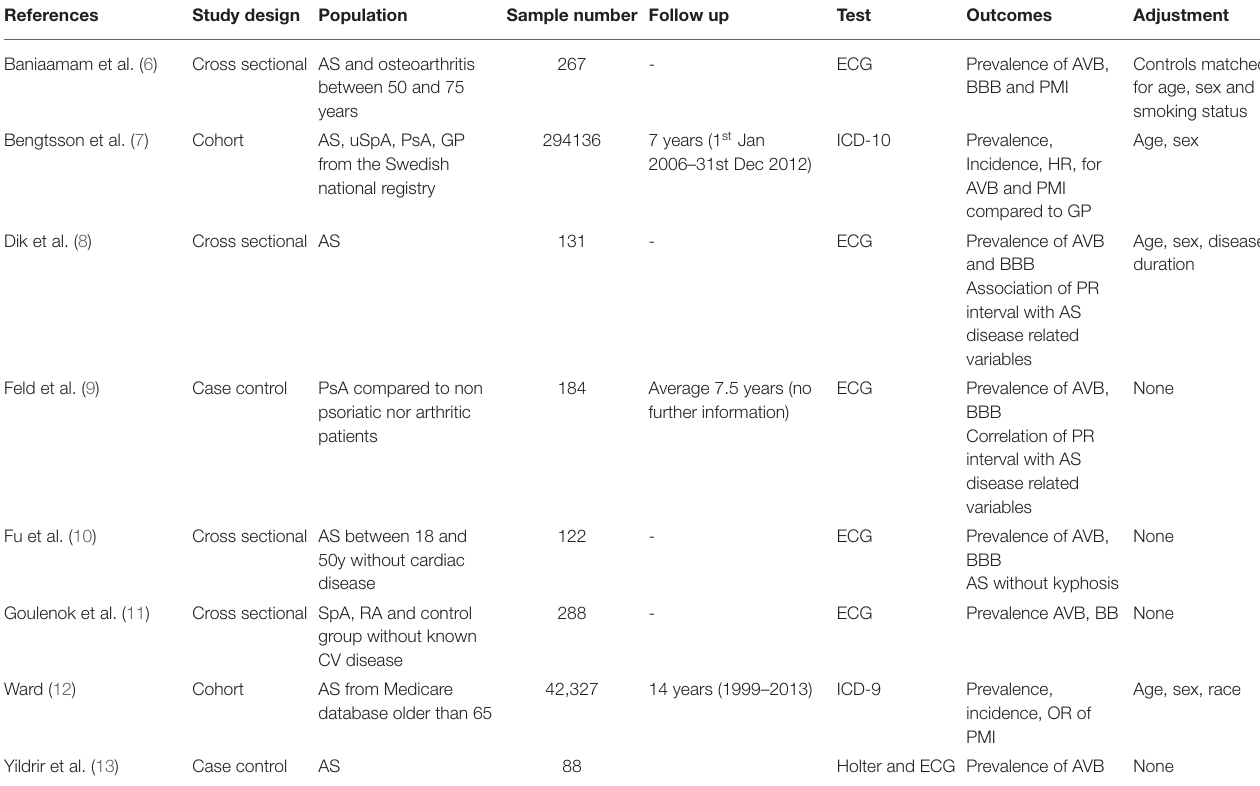
TABLE 1 | Characteristics of the selected studies.